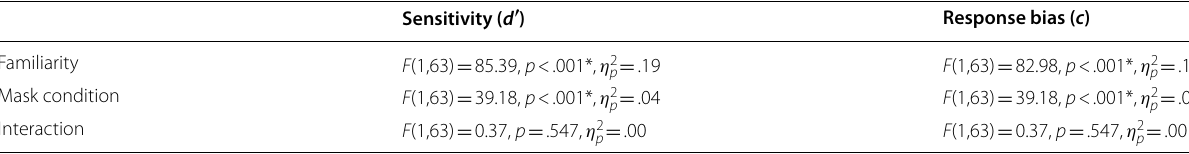
Repeated measures ANOVA for sensitivity ( d ′ ) and response bias ( c ) *Marks statistically significant